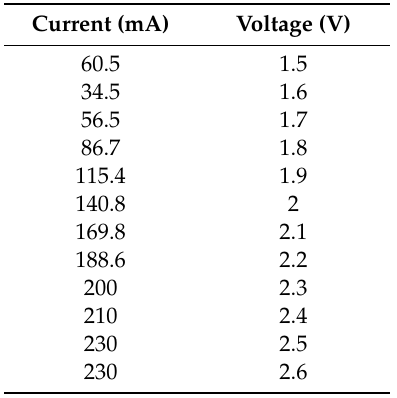
Figure 12. Graph representing relation between current and voltage while charging or during electrolyzer mode of proton battery. Table 7. X and Y axis variable values of the active points shown in Figure 12.